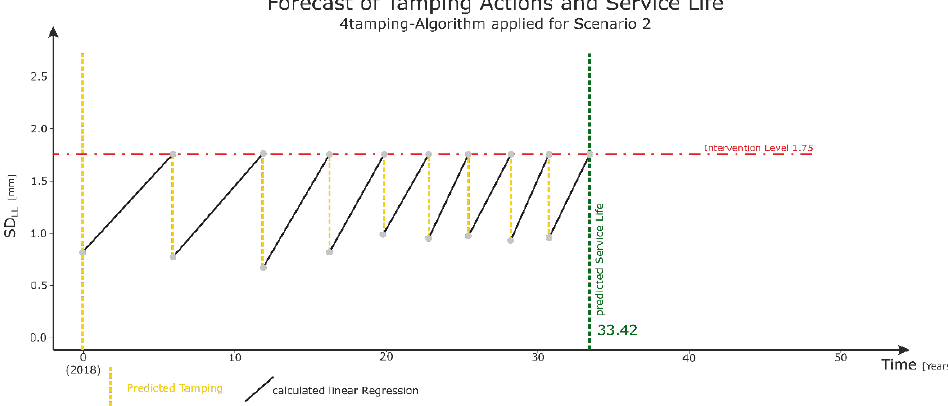
Figure 8. Showing the predicted through-going Tamping Actions and Service Life for the Track Section according to Scenario 2 based on the 4tamping-Algorithm.